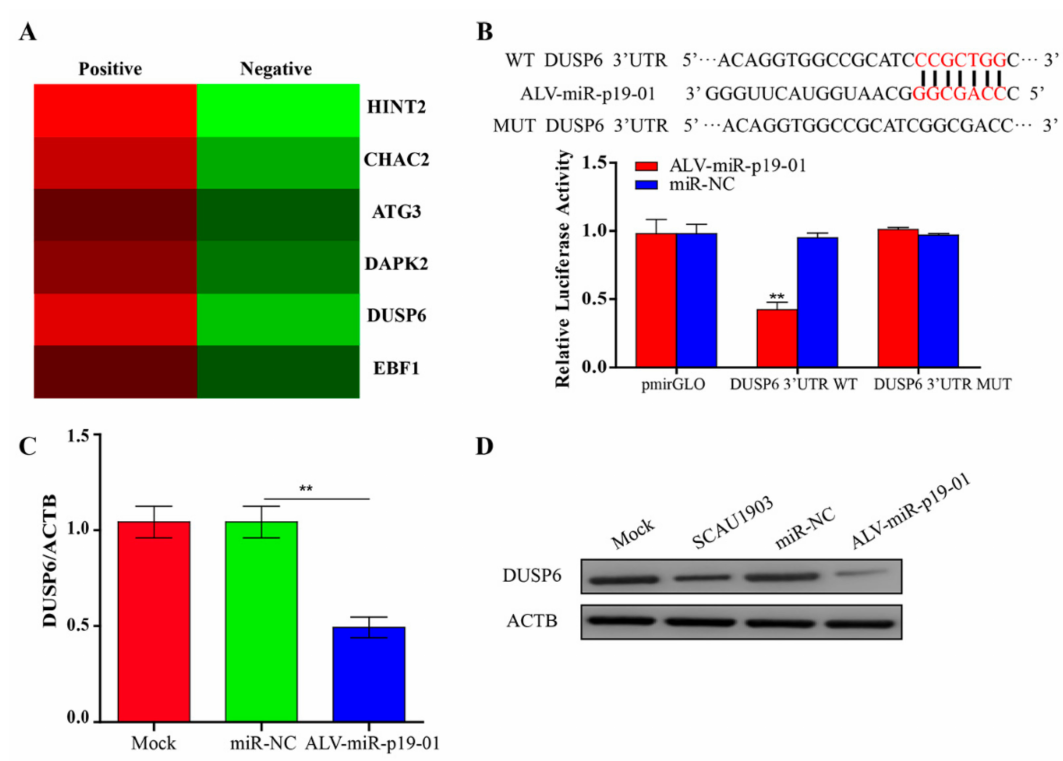
Figure 4. ALV-miRNA-p19-01 targets DUSP6 in DF-1 cells. ( A ) Putative candidate genes enriched from those ALV-miRNA-p19-01 binding genes obtained from RNA-pull down and RNA-sequence. ( B ) Luciferase reporter assays. Bioinformatics predictions of binding sites in DUSP6 3 (cid:48) UTR region. Wild-type (wt) and mutant-type (mut) sequences are indicated. DF-1 cells were co-transfected with